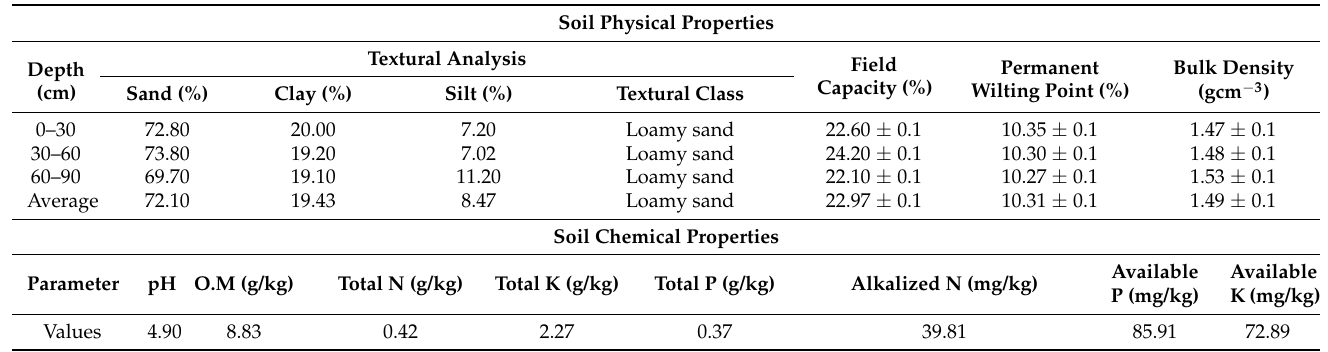
Table 1. General soil physical and chemical